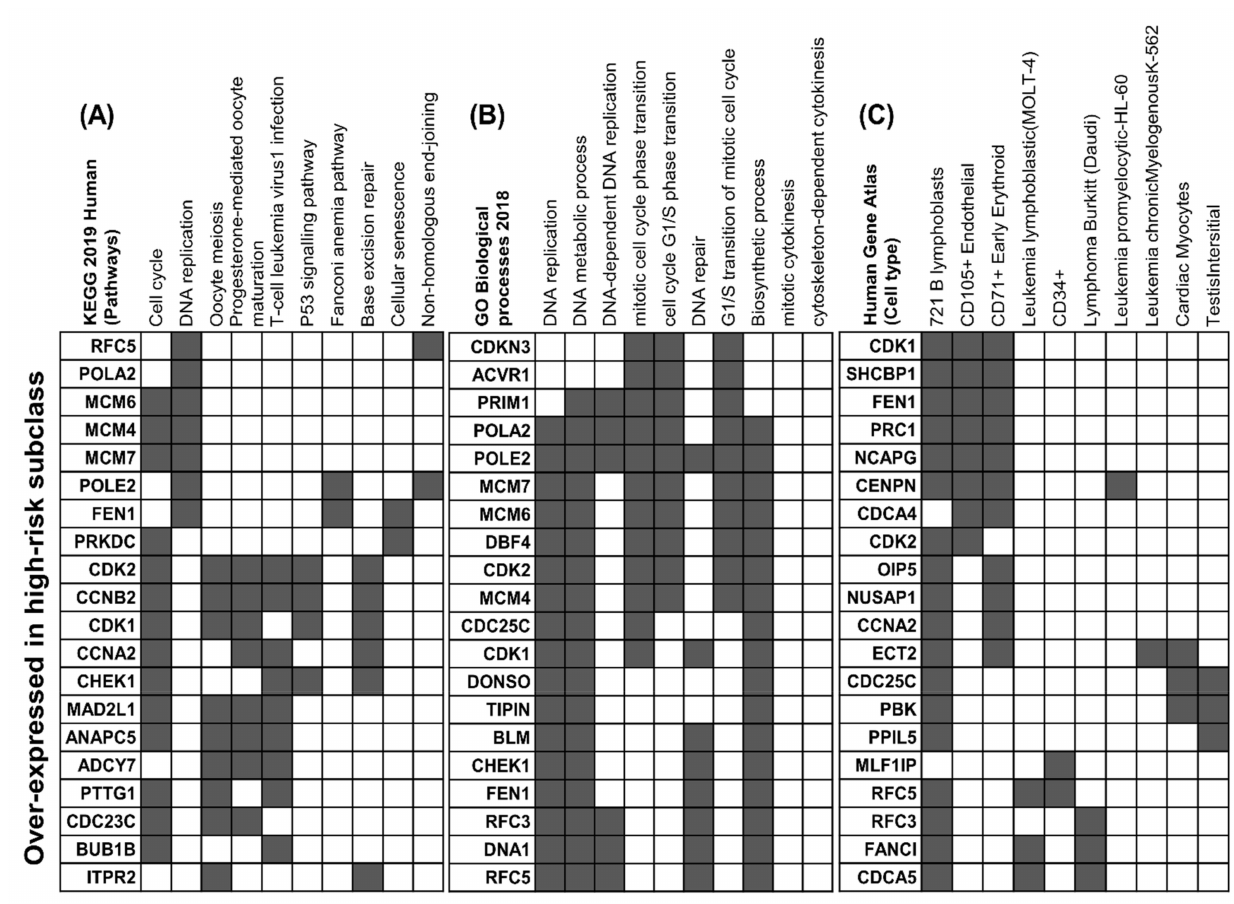
Figure 6. Enriched terms from KEGG 2019 Human pathways, GO Biological processes, and Cell type (Human gene atlas) for ( A – C ) overexpressed